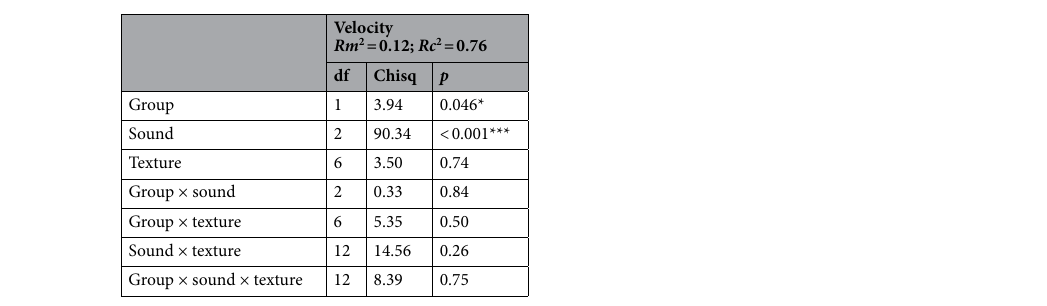
Table 3. Summary of the linear mixed model results for finger movement velocity. Marginal ( Rm 2 ) and conditional ( Rc 2 ) variances explained, degree of freedom (df), chi-square (Chisq) and p-value ( p ) are